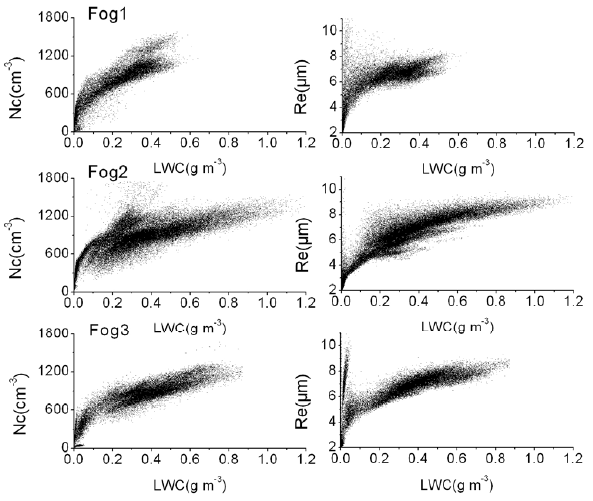
Fig. 7. The Nc and effective radium (Re) versus LWC in the three fog events.